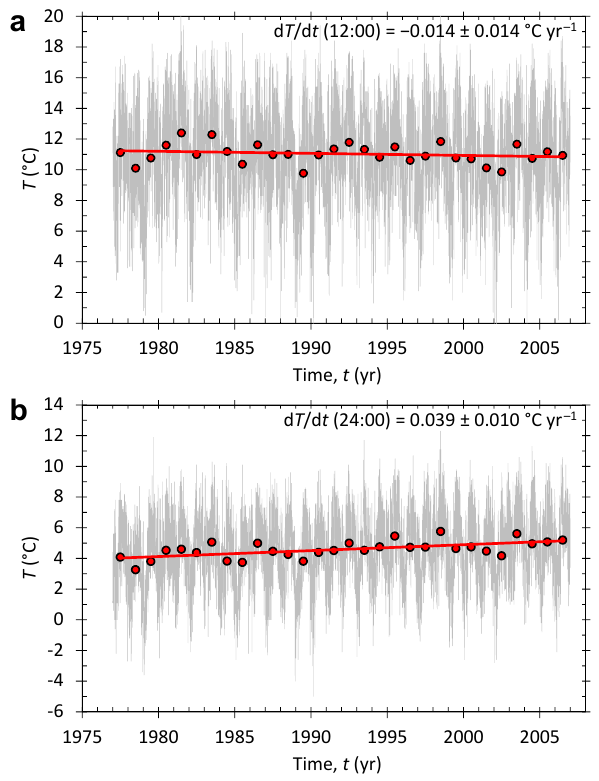
Fig. 1. Temperatures at (a) 12:00LST (noon) and (b) 24:00LST (midnight) at the Mauna Loa Observatory, Hawaii, 1977–2006, based on hourly temperature data from NOAA (2009). Shown are the 30-yr daily sequence of noon and midnight tempera- tures T (light grey lines) as a function of time t from 1 Jan- uary 1977 to 31 December 2006. Also shown (circles) are the annual means of these daily values. The best-fit line us- ing ordinary least-squares is shown for both times (thick solid line), with slopes d T /d t (12:00)= − 0.014 ± 0.014 ◦ Cyr − 1 and d T /d t (24:00)= − 0.039 ± 0.010 ◦ Cyr − 1 (uncertainties ± 1s.e. of the